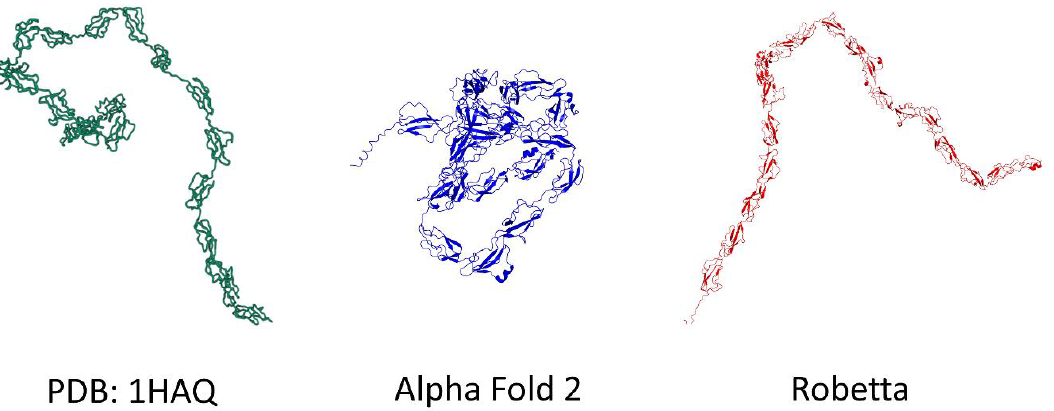
Figure 7. Comparison of Xray diffraction (PDB: 1HAQ), AlphaFold2 and Robetta models for com- plement factor H. In the case of this highly flexible protein, AlphaFold2 predicts a globular shape whereas Robetta’s model is rather elongated.